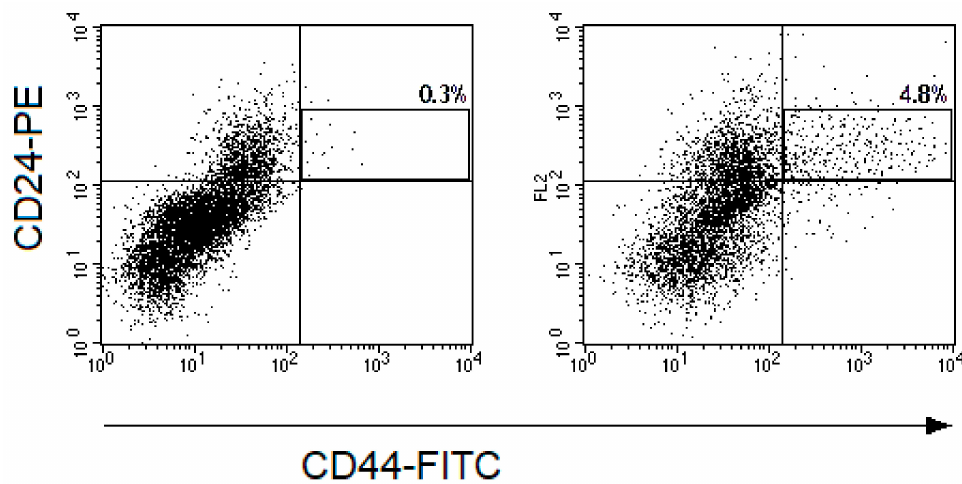
Figure 3. Representative dot plots for CD44-FITC and CD24-PE fluorescence of cells from cervical scrapings from the patient with CC: ( a ) before the treatment and ( b ) 24 h after irradiation at a TD of 10 Gy. The cell suspensions were stained with monoclonal antibodies to CD24-PE, CD44-FITC, CD45- PE-Cy5, and Hoechst 33342 DNA-binding dye. The gate of CD45 - Hoechst33342 + events was selected and fluorescence of cells with CD44 and CD24 antibodies were evaluated in this gate. The region of CD44 + CD24 low CSCs is highlighted on the dot plots presented. The percentages of CD44 + CD24 low cells among CD45 - Hoechst33342 + events are indicated on the plots.